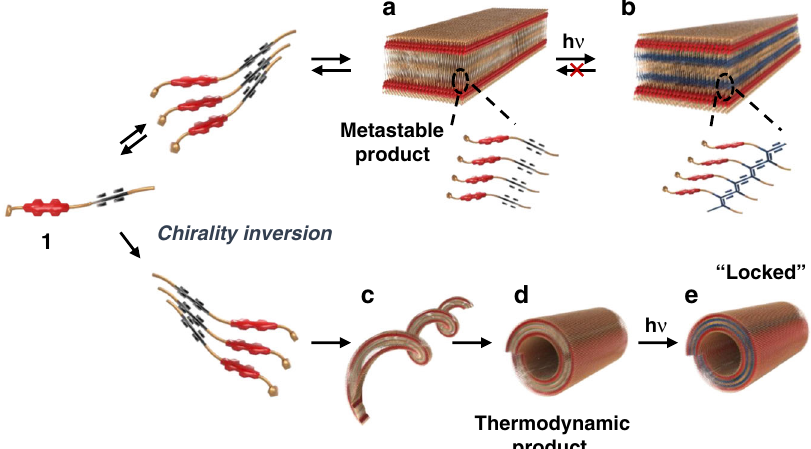
Fig. 6 Pathway for self-assembly of 1. A kinetically favored metastable nanoribbon is generated in an initial nucleation step ( a ). UV irradiation of this kinetic intermediate promotes polymerization and prevents dissasembly of the nanorribbon ( b ). Without UV irradiation, the initially generated nanoribbon dissociates to form monomers, which reassemble to yield a helical intermediate ( c ), which is slowly transformed into the thermodynamically stable nanotube with inversion of the supramolecular chirality ( d ). Polymerization of diacetylene units in the nanotube by using UV light irradiation affords covalent modi fi cation of the tube ( e